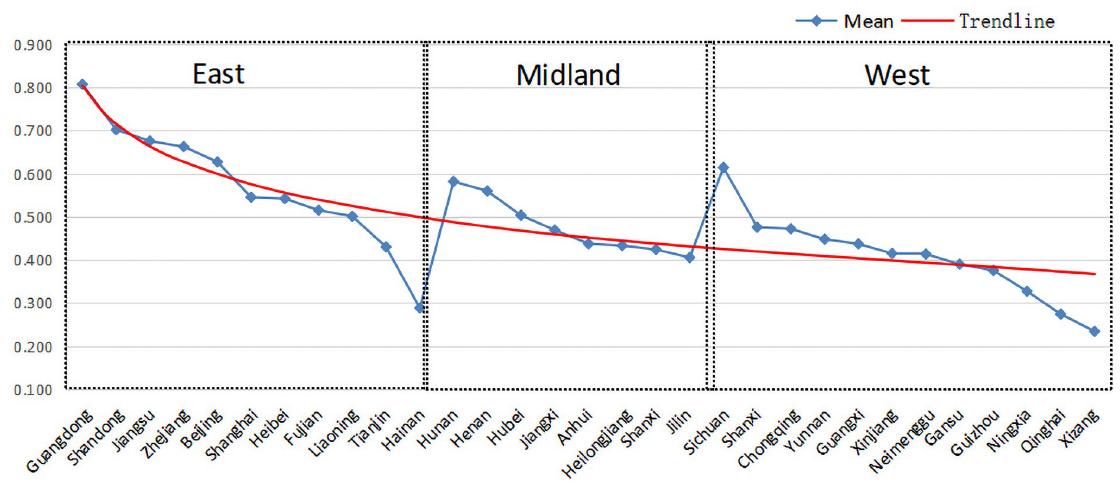
Fig 2. The mean value of index of coupling coordination degree of 31 provinces and cities in China within five years.